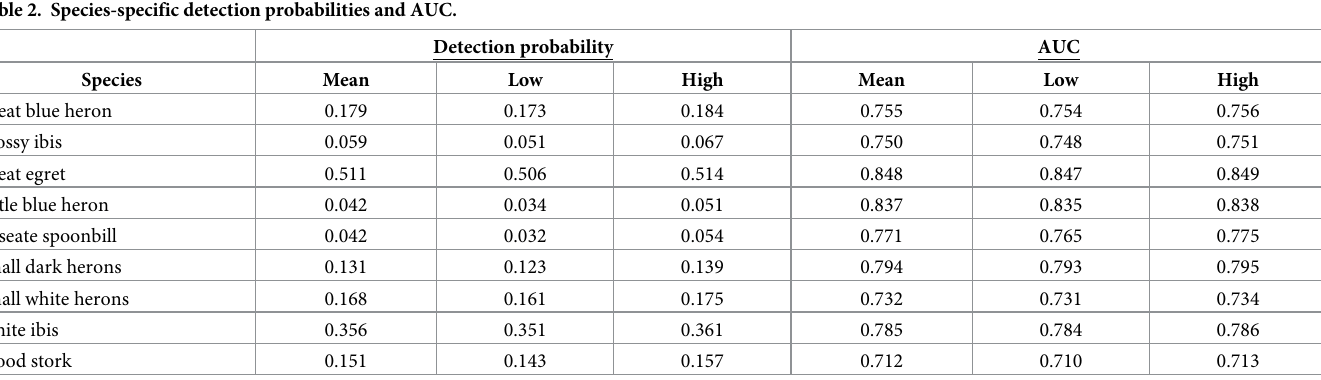
Table 2. Species-specific detection probabilities and